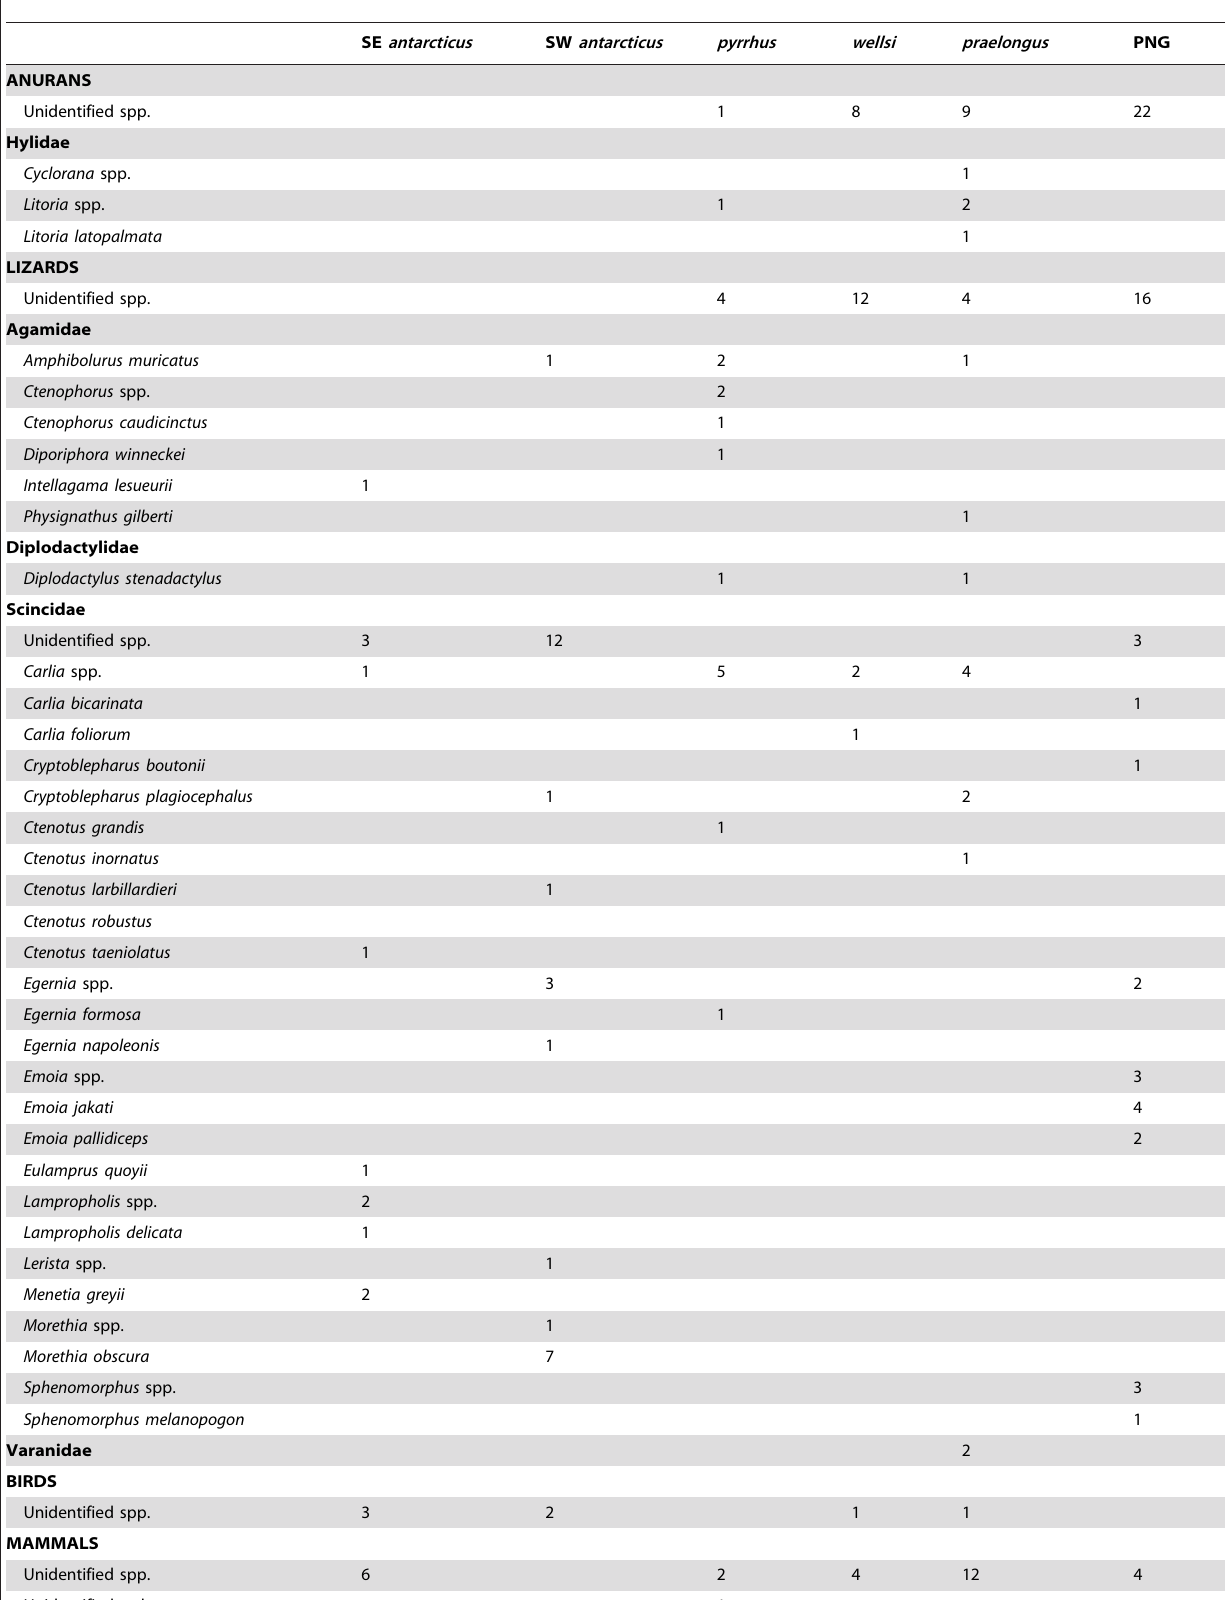
Table 1. Prey items identified from dissection of museum specimens of death adders, genus Acanthophis .